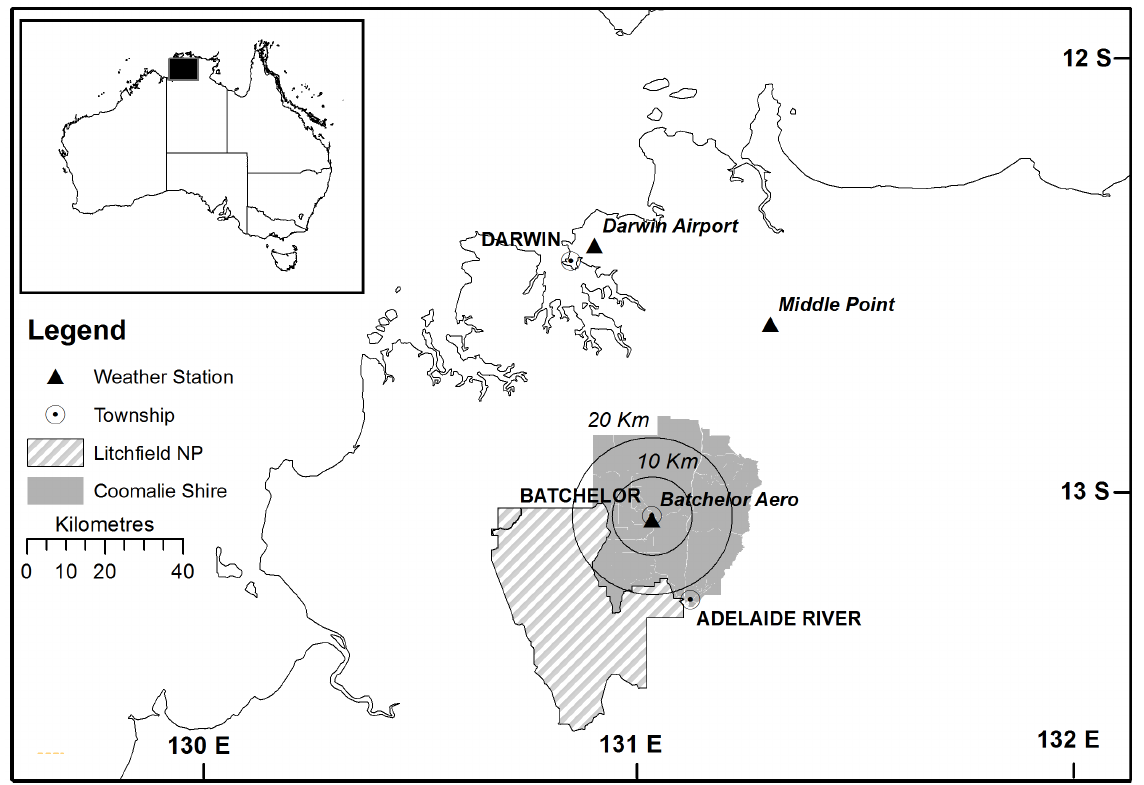
Figure 1. Location map showing: (1) study area (Coomalie Shire and Litchfield National Park) and (2) the Bureau of Meteorology weather stations (Batchelor Aero, Middle Point and Darwin Airport) in the Northern Territory, Australia. Circles showing 10 and 20 km radius around Batchelor were the areas used to determine fuel load.